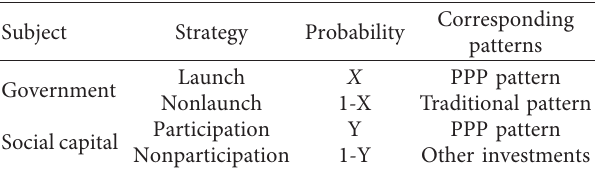
Table 2: Optional strategies of government and social capital and their